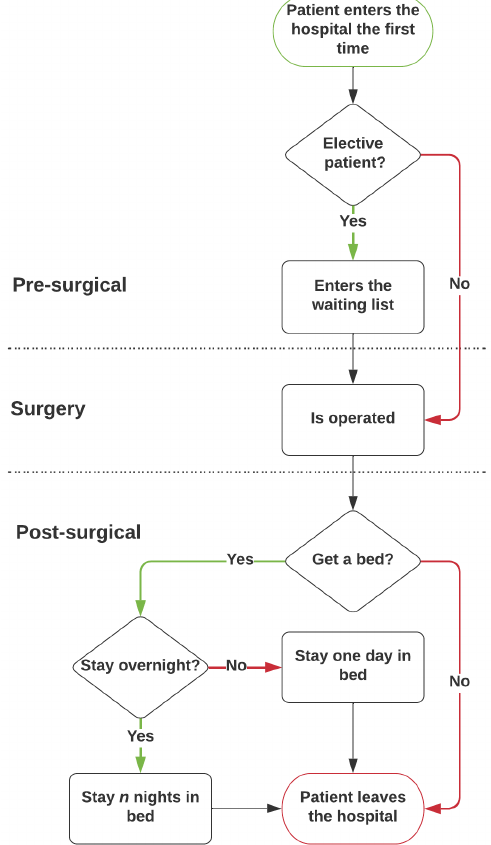
Figure 1. Patient flow requiring a